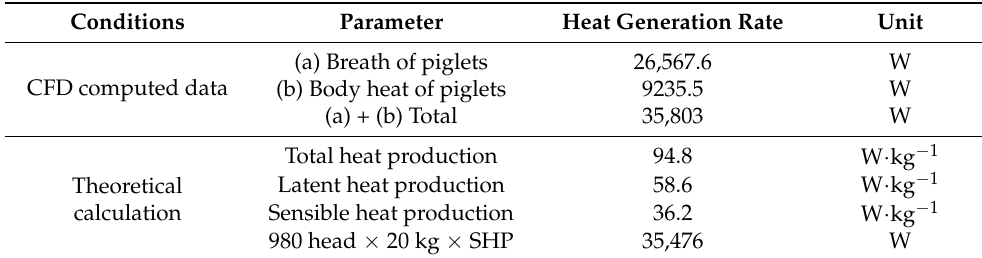
Table 4. CFD computed results of respiration and body heat production of piglets and calculated results of theoretical heat